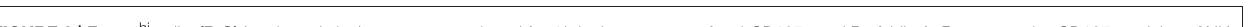
FIGURE 6 | Eomes hi cells. (B,C) Intrahepatic leukocytes were cultured for 4h in the presence of anti-CD107a and Brefeldin A. Representative CD107a staining of NK cells from a healthy (B) and a NAFLD (C) liver is shown. (D) Inverse correlation between NK cell degranulation and histological score in human livers. H, healthy; SS, simple steatosis; NAS, NASH Activity Score; C, cirrhosis. Significance was determined using Spearman’s Rank Correlation. (E) CD56 + CD3 − CD16 + CXCR6 − NK cells were sorted from healthy ( n = 4) and NAFLD ( n = 3) livers and cultured for 4h with the human NK target cell, K562. At the end of culture, target cell death was assessed using AnnexinV staining. (F) Inverse correlation between liver-resident NK cell degranulation and histological score in human livers. Significance was determined using Spearman’s Rank Correlation. (G) CD56 + CD3 − CXCR6 + liver-resident NK cells were sorted from healthy ( n = 4) and NAFLD ( n = 3) livers and cultured for 4h with the human NK target cell, K562. At the end of culture, target cell death was assessed using AnnexinV staining. For (E,G) , medians are shown. For these small datasets, no statistical testing was carried